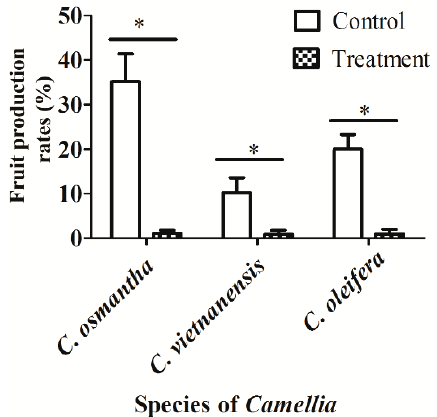
Figure 5. Effect of insect pollination on the fruit production rates of Camellia osmantha , C. vietnamensis , and C. oleifera . Asterisks indicate a significant difference between the two groups based on paired samples t -test at p < 0.05.